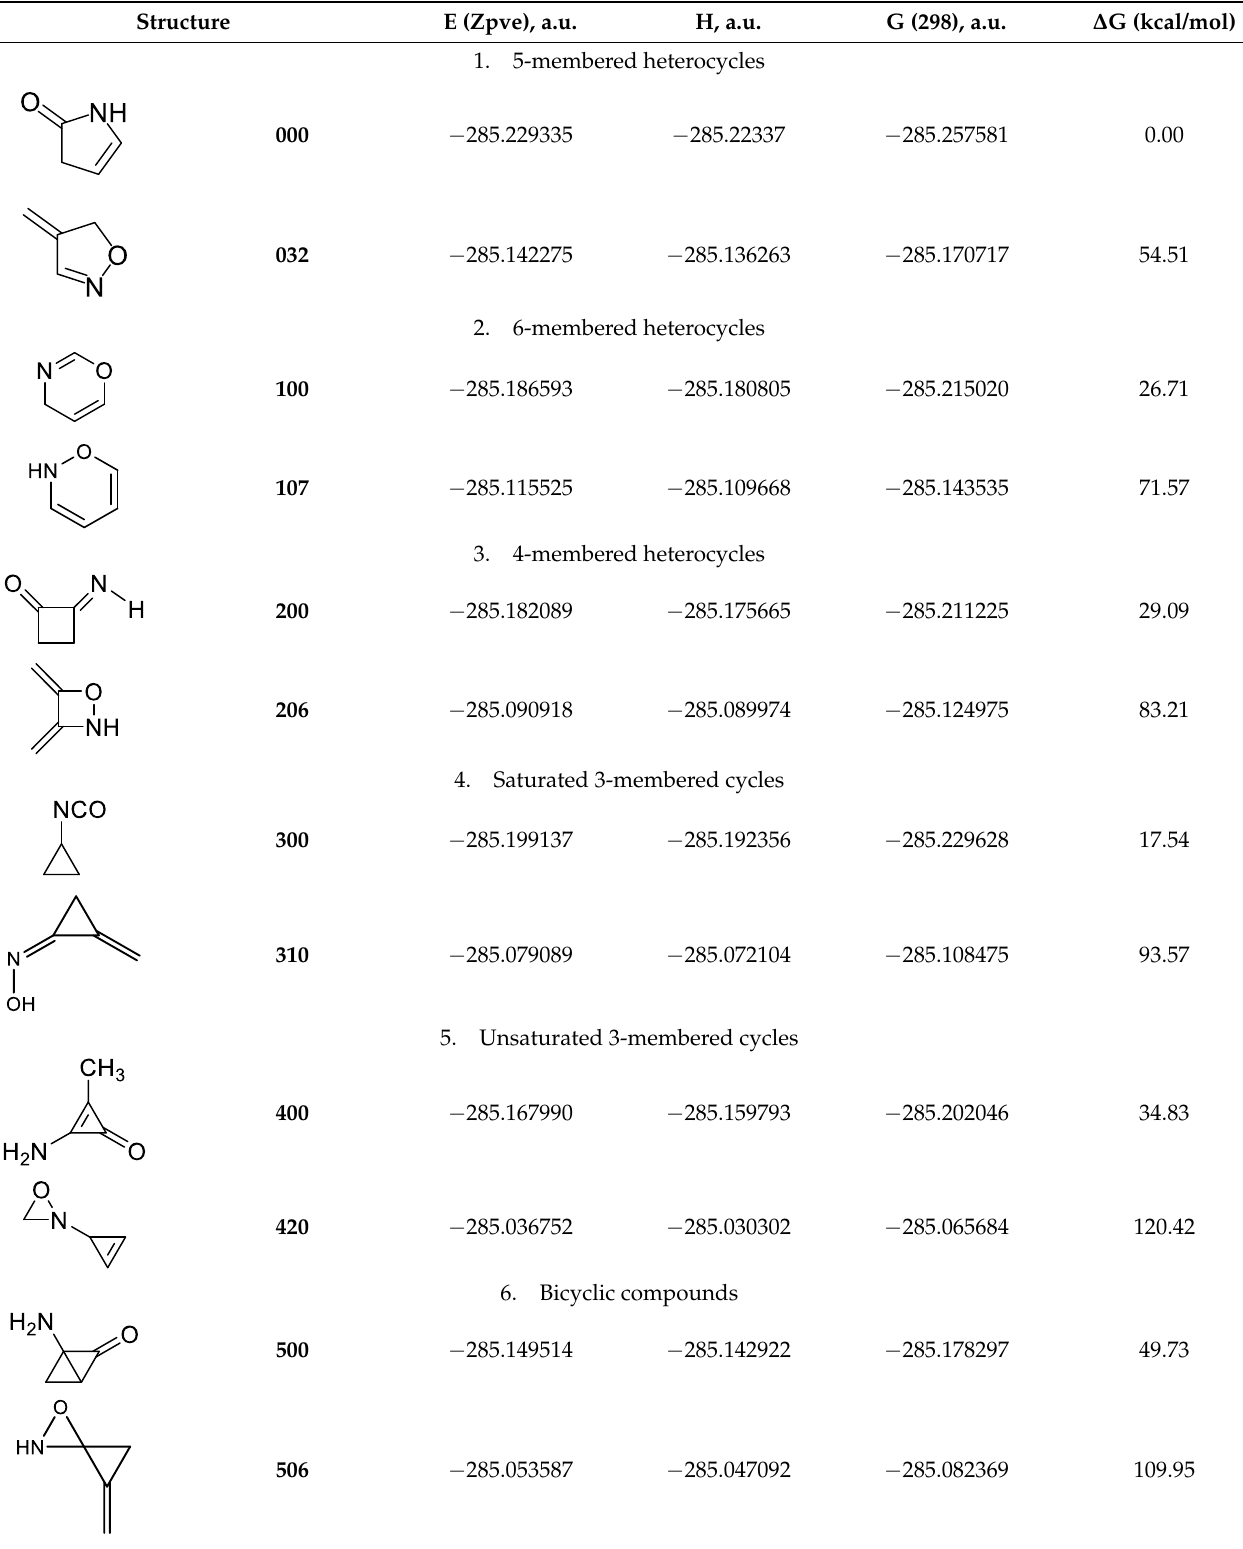
Table 1. Thermodynamic parameters of C 4 H 5 NO molecules with the lowest and highest energy within the structural group.